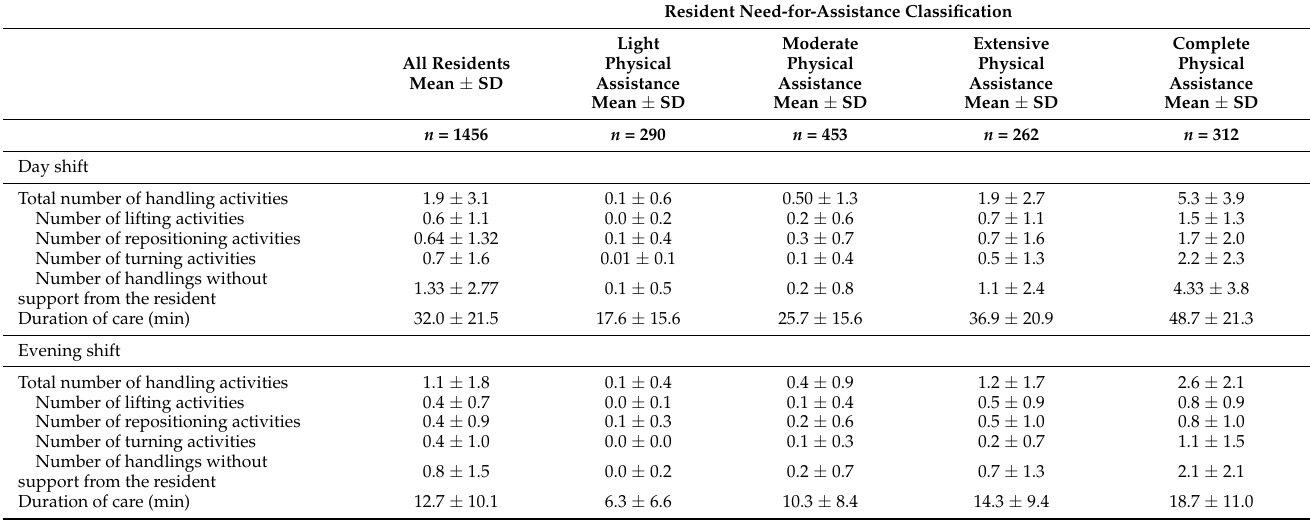
Table A1. Descriptive results of the residents’ observed need for physical assistance according to the resident need-for-physical-assistance scale on day and evening